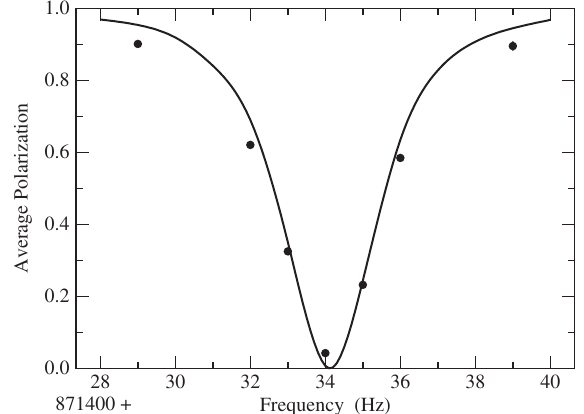
FIG. 20. Measurements of the average oscillating polarization for frequencies on either side of the rf-solenoid spin resonance. The model calculations shown by the curve include the shift of the resonance position from Table III. These measurements were made with cooled